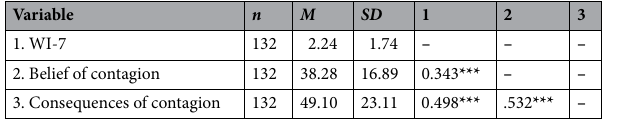
Table 1. Descriptive statistics and correlations for study variables. ***p <